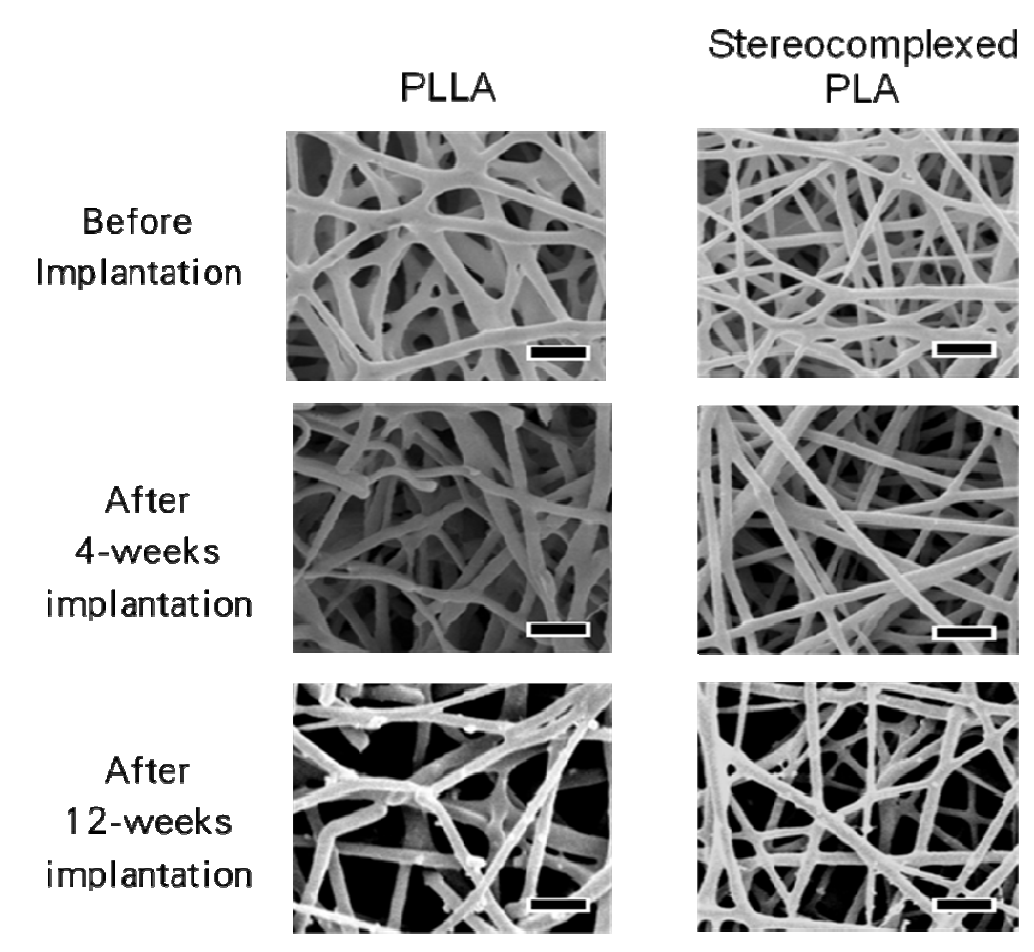
Figure 12. SEM images of PLA nanofiber scaffolds after subcutaneous implantation in rat for 4 to 12 weeks. Scale bars = 1 μ m